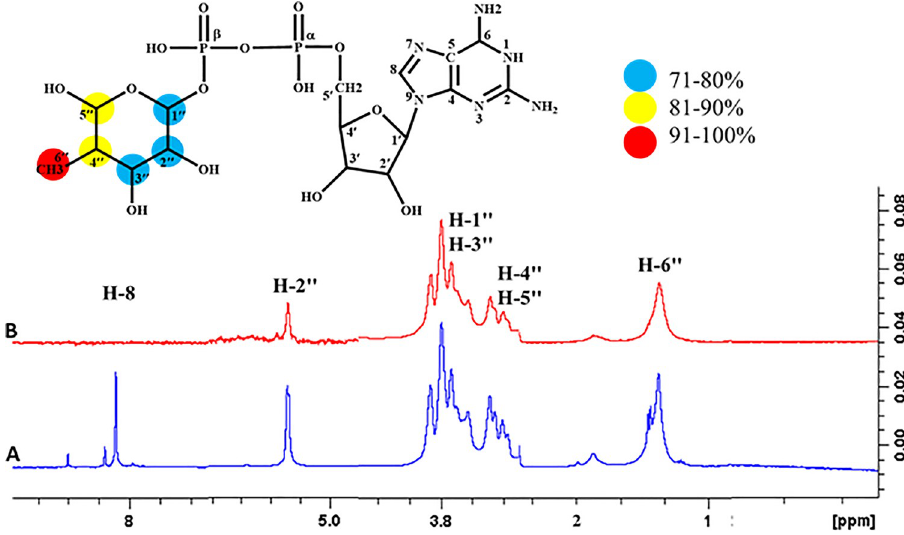
Fig 14. (A ) Reference 1 H-NMR spectrum of GDP- Fucose. ( B) Difference spectrum of GDP- Fucose with the enzyme.